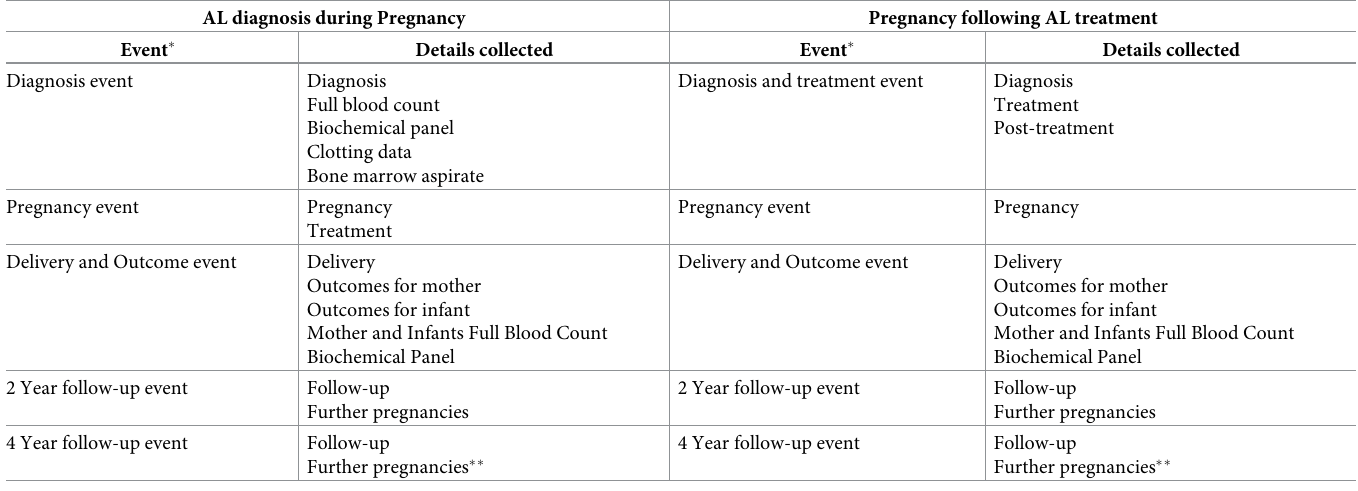
Table 1. Schedule of